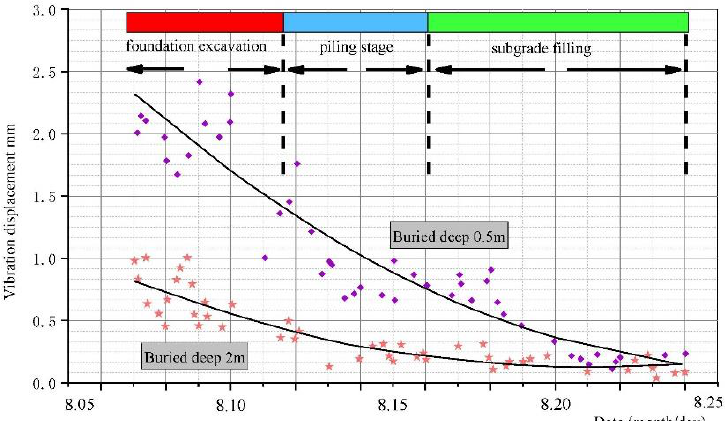
Figure 6. Foundation soil vibration displacement — depth distribution rule.